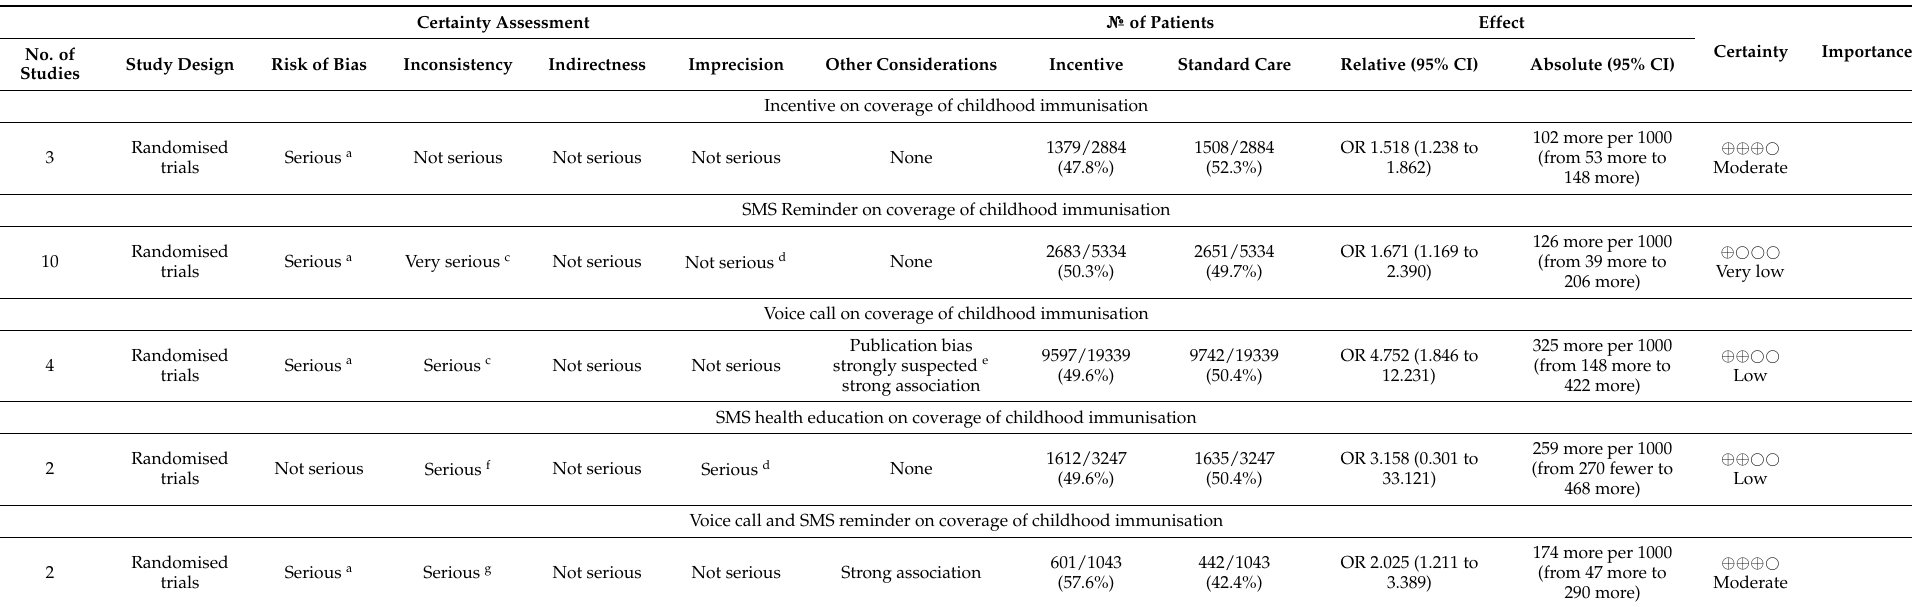
Table 4. Certainty of evidence for interventions on coverage of childhood